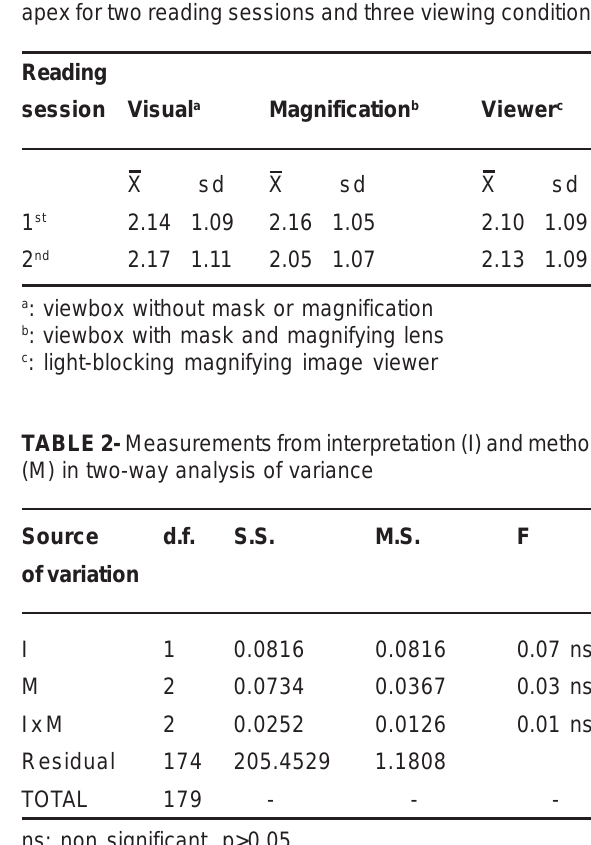
ns: non significant,